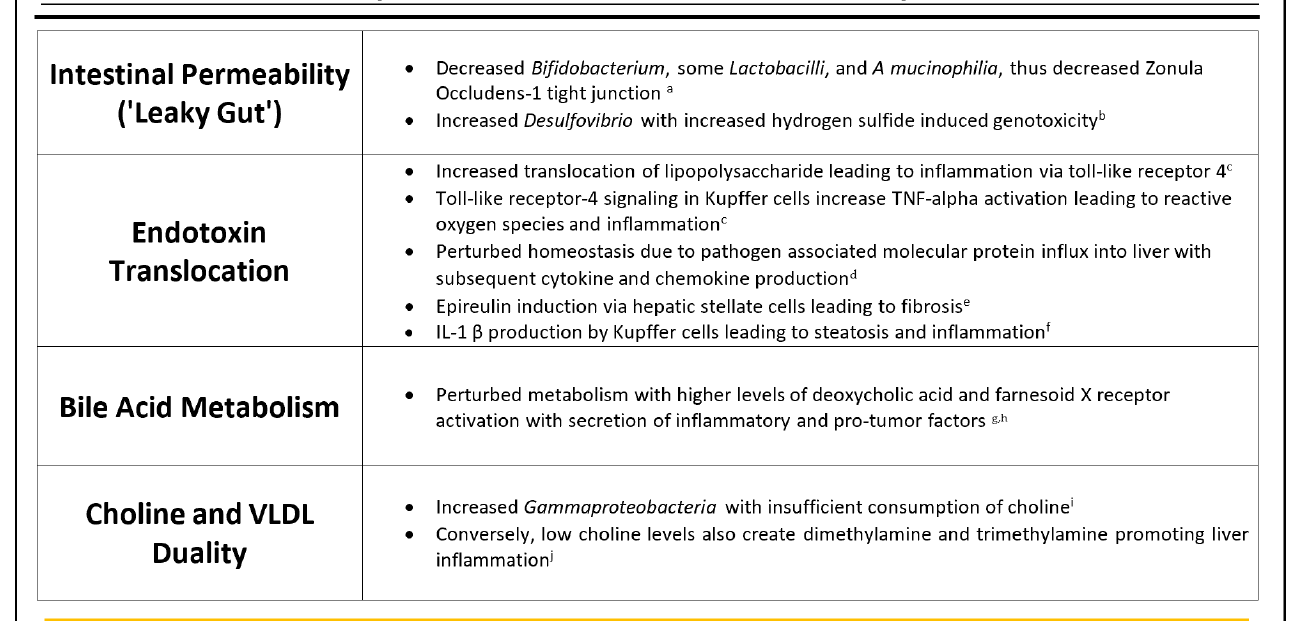
Figure 1. Table depicting the role of leaky gut, endotoxin translocation, bile acid metabolism, choline, and vLDL duality in NAFLD. a Lam et al., 2012 [18], b Lam et al., 2015 [19], c Kolodziejczyk et al., 2019 [20], d Dapito et al., 2012 [21], e Schwab et al., 2020 [22], f Raza et al., 2019 [23], g Yoshimoto et al., 2013 [24], h Takahashi et al., 2018 [25], i Spencer et al., 2011 [28], j Chu et al., 2018